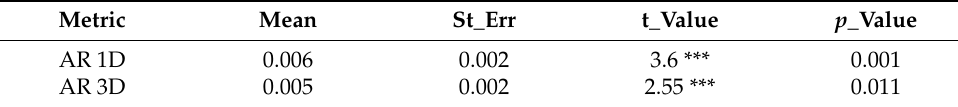
Table 6. AR around transaction finalization for energy firms’